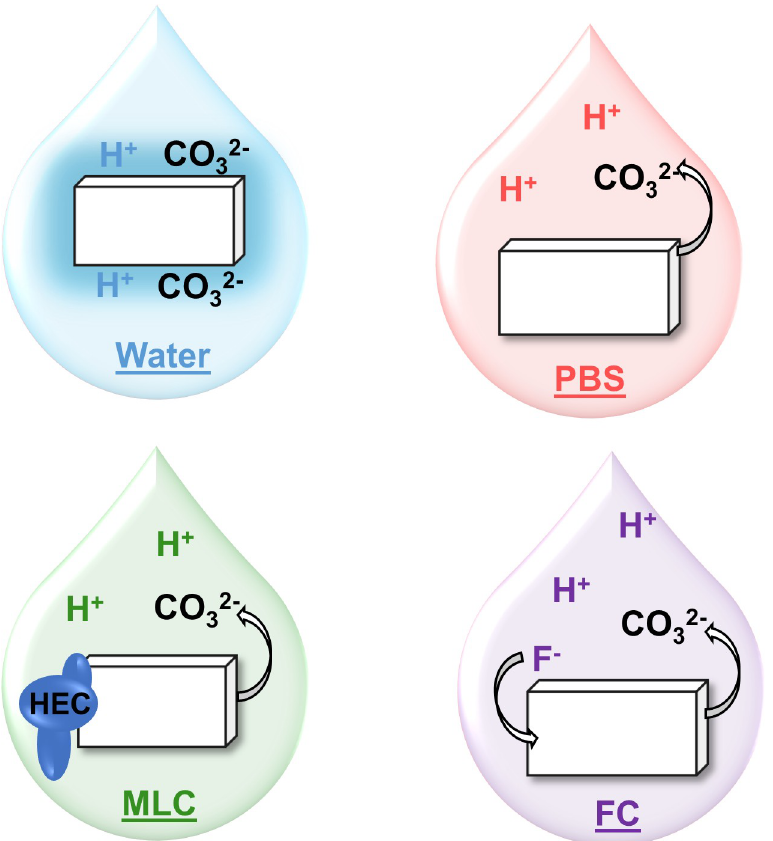
Fig 8. Summary of dissolution mechanism of CAP in each solution. Water does not affect apatite erosion and leaves labile carbonate on the crystal surface. The addition of phosphorus in solution allows carbonate to be released from apatite to buffer the acid in the solution. MLC has a similar mechanism, however, mucin-like molecules binding to apatite may affect apatite erosion. While carbonate is dissolved from apatite into FC to buffer the acid, fluoride may be incorporated into apatite during